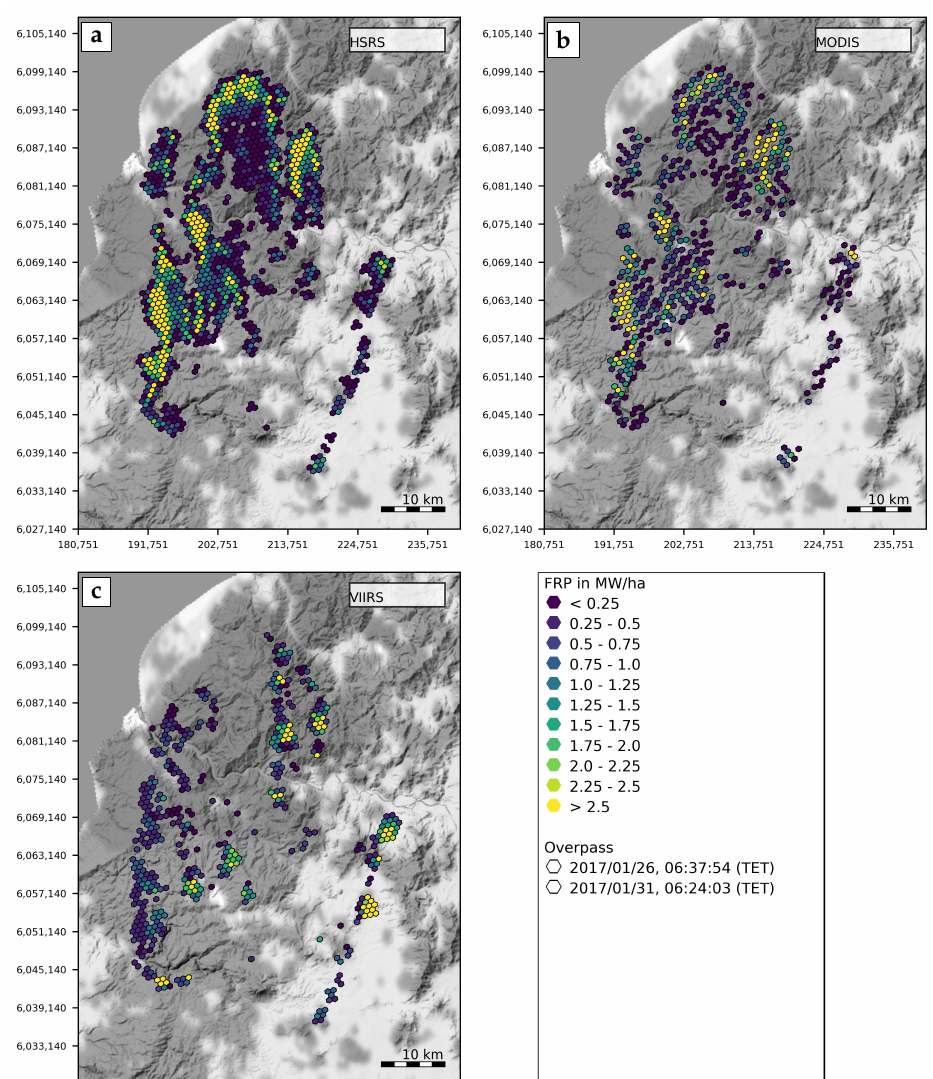
Figure 5. FireBIRD active fire data (derived using the MWIR method) and reference data for a fire event in Chile, January 2017. ( a ) shows active fires derived from two FireBIRD/HSRS overpasses (26–31 January 2017), pigmented by FRP. ( b ) shows MODIS active fire data of the Aqua/Terra over- passes in closest temporal vicinity to the respective FireBIRD overpasses. ( c ) shows VIIRS active fire data of the two Suomi-NPP overpasses in closest temporal vicinity to the respective FireBIRD overpasses. Background: Stamen/OpenStreetMap shaded terrain map, shown in gray